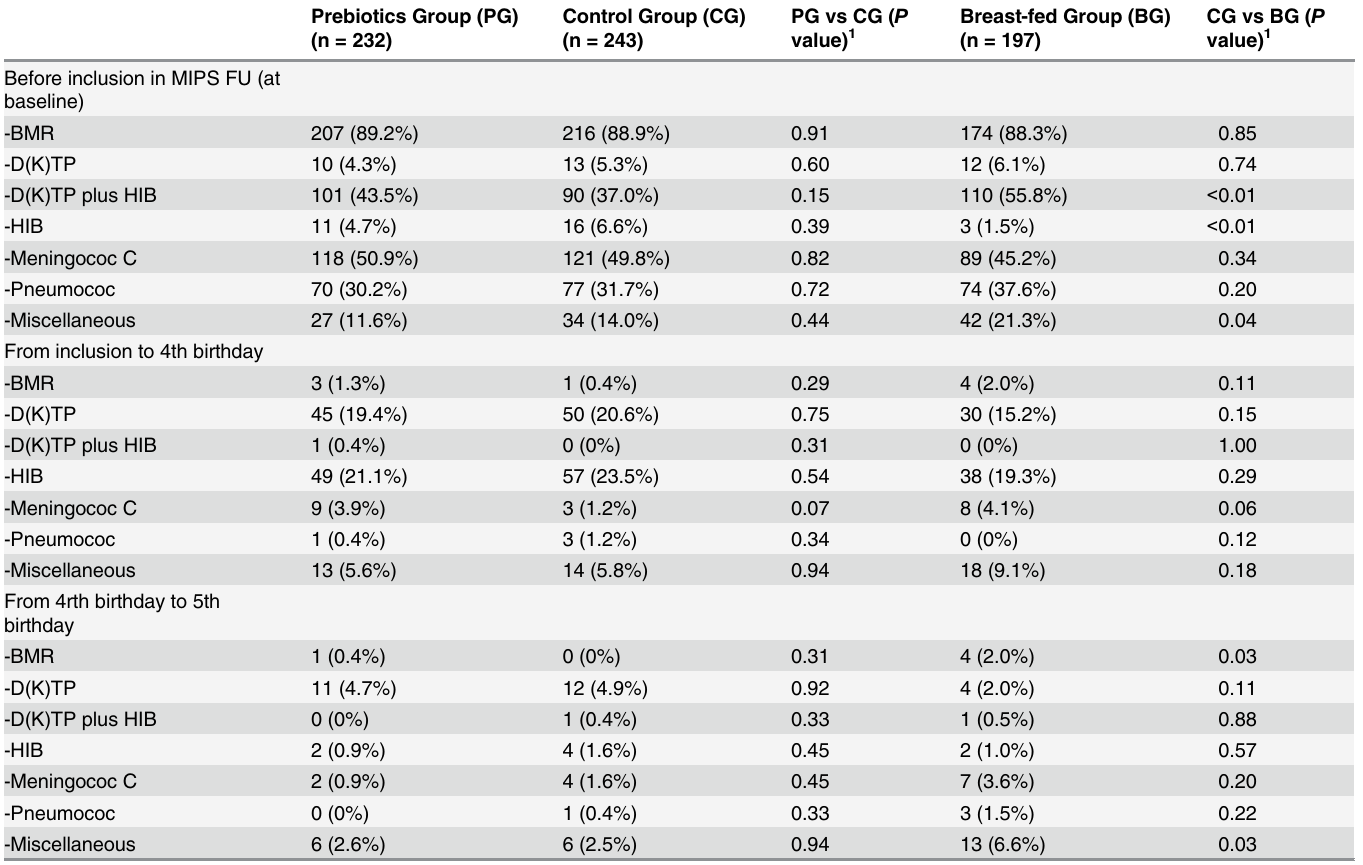
Table 3. Vaccination data: number and percentage of children who received vaccinations before inclusion of MIPS Follow Up and during MIPS Fol- low Up,